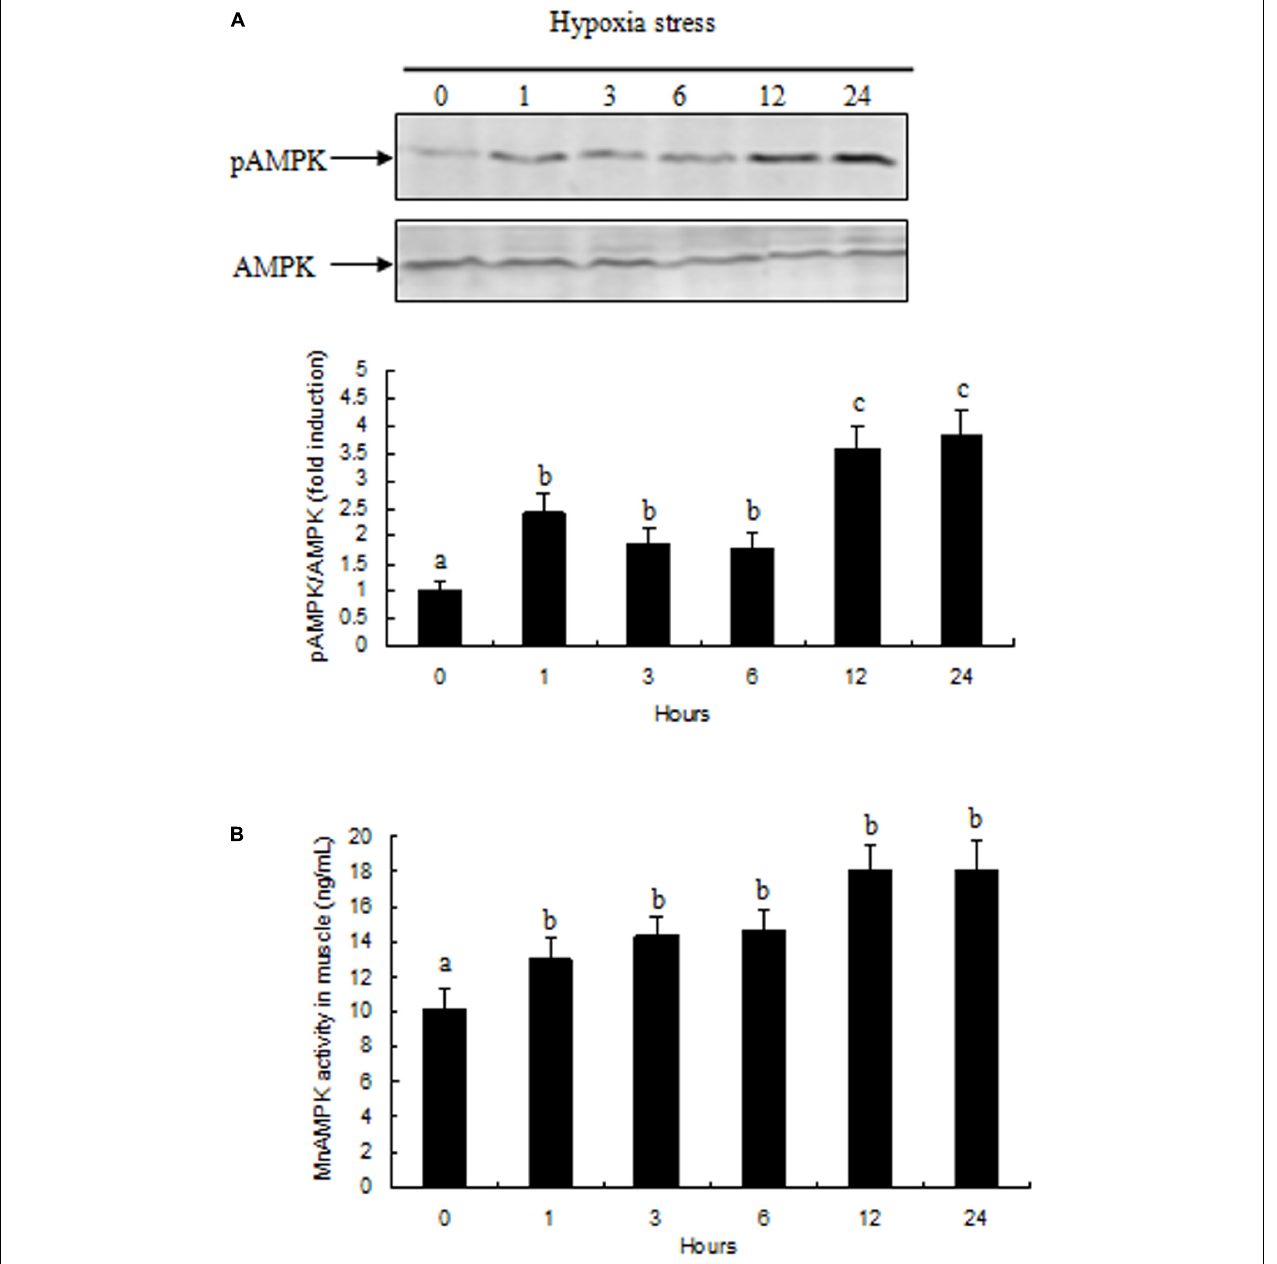
FIGURE 4 | Effects of hypoxia on AMPK activity in muscle of M. nipponense . (A) pAMPK/AMPK abundance are represented as a fold induction over basal levels observed in the normoxia group at time 0 h. (B) Changes in AMPK enzyme activity in response to hypoxia in muscle of M. nipponense . Results are expressed as mean ± SE ( n = 9). Different letters indicate significant differences among all treatment groups ( P <